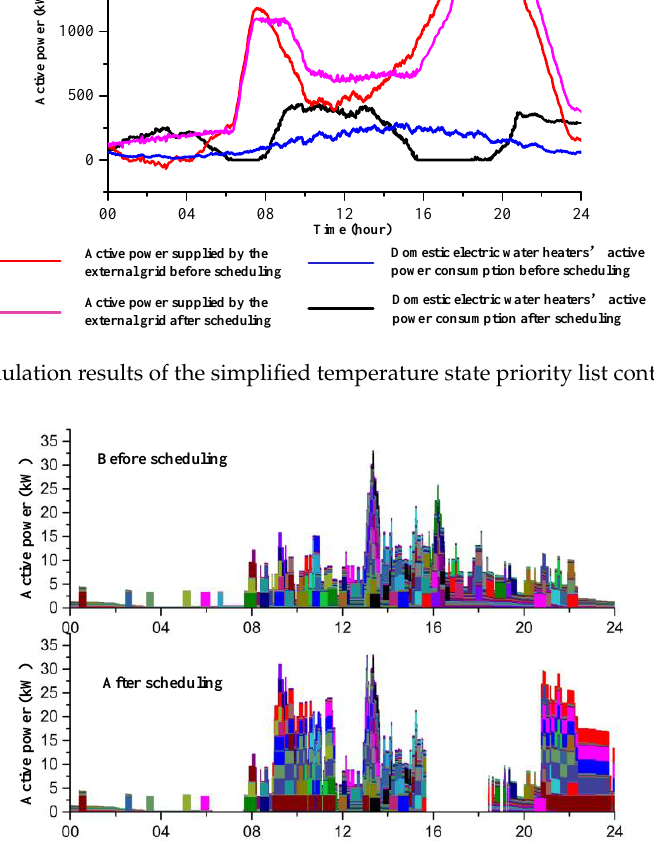
Figure 9. Real time active power consumption of 100 domestic electric water heaters based on the simplified temperature state priority list method.